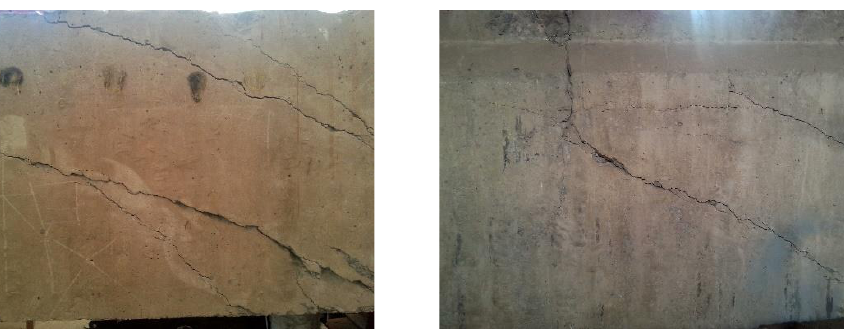
Figure 4. Arrangement of the repaired beam under four-point bending test. Two concentrated loads were applied step by step on the top surface of the repaired beam. As shown in Figure 5, each load was exerted by a hydraulic jack, and controlled by a load meter. Based on the specification of China code JTG 3362 [41], the maximum transverse distribution coefficient of moving vehicles on the old bridge was 0.238. At the servicea- bility limit state and the bearing capacity limit state, the target moment at the mid-span section were 892.0 kN  m and 955.0 kN  m, respectively. Therefore, the corresponding ap- plied moments were 653.5 kN  m and 716.5 kN  m, calculated by subtracting the bending moment caused by self-weight. In this study, the target load was determined with the bending moment at the ser- viceability limit state. Therefore, each concentrated load on the top surface of the re- paired beam was 109.8 kN, denoted by P 0 . The loading step followed as 0.2, 0.4, 0.6, 0.8, 0.85, 0.9, 0.95, and 1.0 times the target load P 0 .